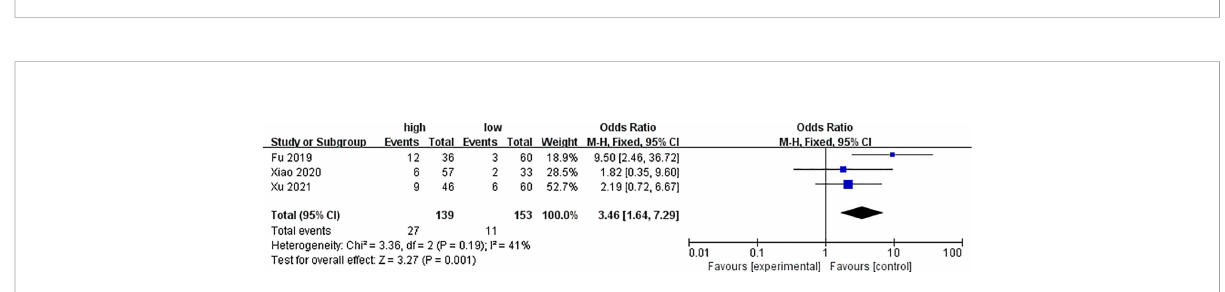
FIGURE 6 Forest plot of meta-analysis of the relationship between PYCR1 expression and distant metastasis of cancer.